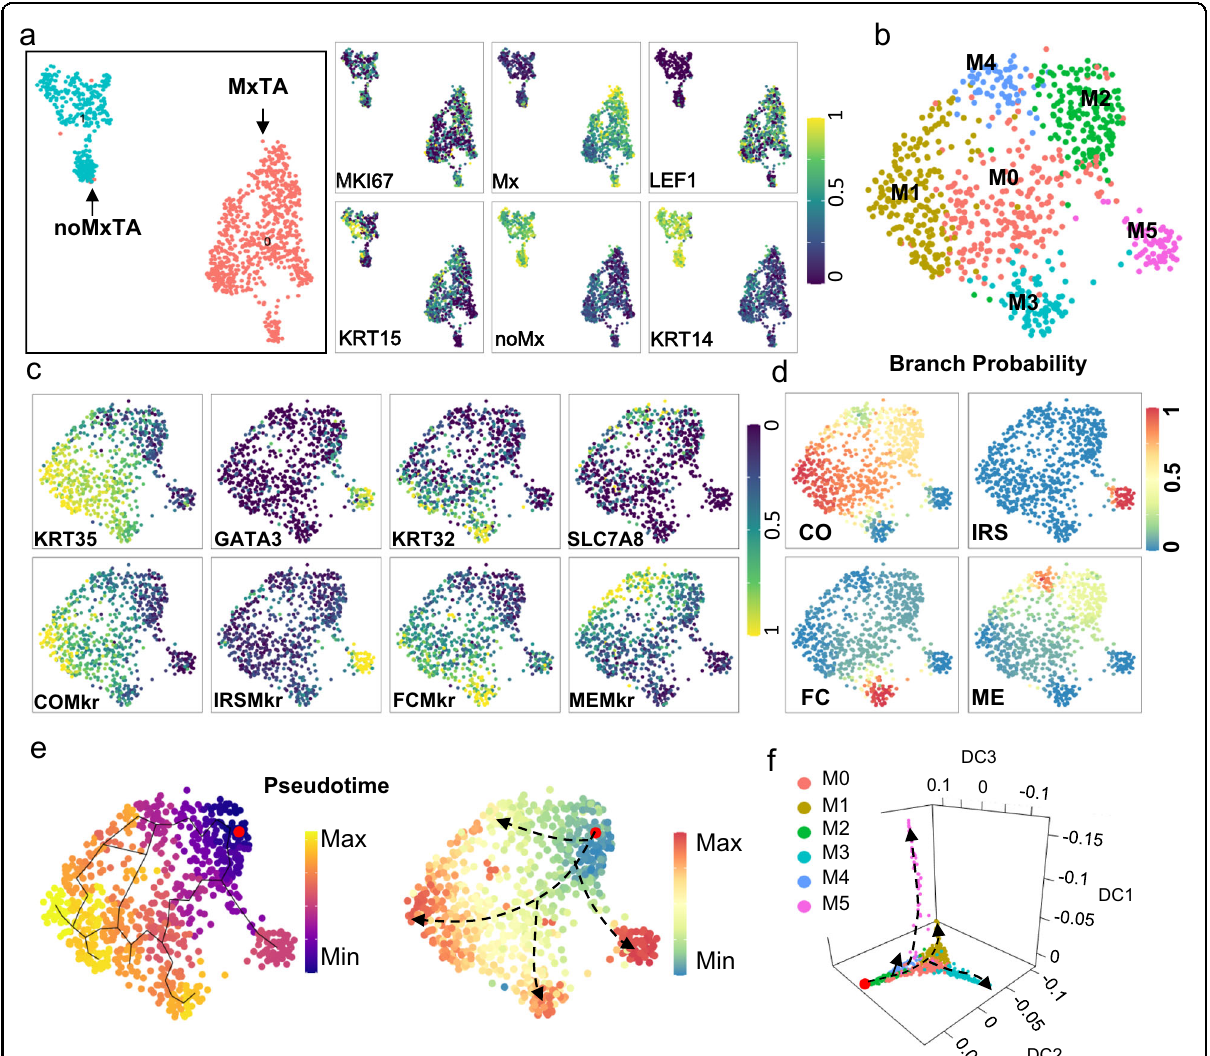
Fig. 3 Human HF TAC contains heterogeneous populations with distinct lineage tendencies. a Subclustering of PR cells and marker genes expression visualized on UMAP. b Subclustering UMAP of MxTA cells from a . c Representative marker genes expression visualized on MxTA subclustering UMAP. COMkr: CO markers; IRSMkr: IRS markers; FCMkr: FC markers; MEMkr: ME markers. d Palantir branch probabilities for CO, IRS, FC, and ME cell lineages in Matrix TA cells. Cells were colored according to their Palantir branch probabilities. e UMAP visualization of Matrix TA cells, but with cells now colored according to their monocle3 pseudo-time (left) and diffusion pseudo-time (right), respectively. The root cell was indicated in red. f Diffusion map of the single cells along the top three diffusion components (DC). Cells were colored according to subclusters in b . The root cell was indicated in red and putative lineage trajectories displaying the bifurcation into CO, IRS, FC, and ME lineages were shown in